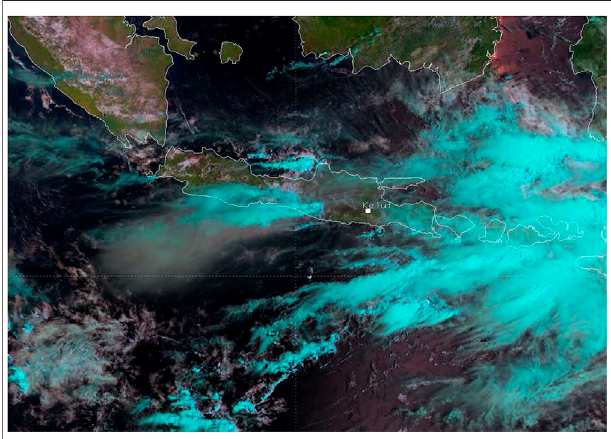
FIGURE 14 | Natural color RGB image of Kelut ash cloud (diffuse gray area), taken c. 2 h after the eruption, shows WSW drifting of cloud, consistent with probabilistic estimate of work fl ow. (EUMESTAT,